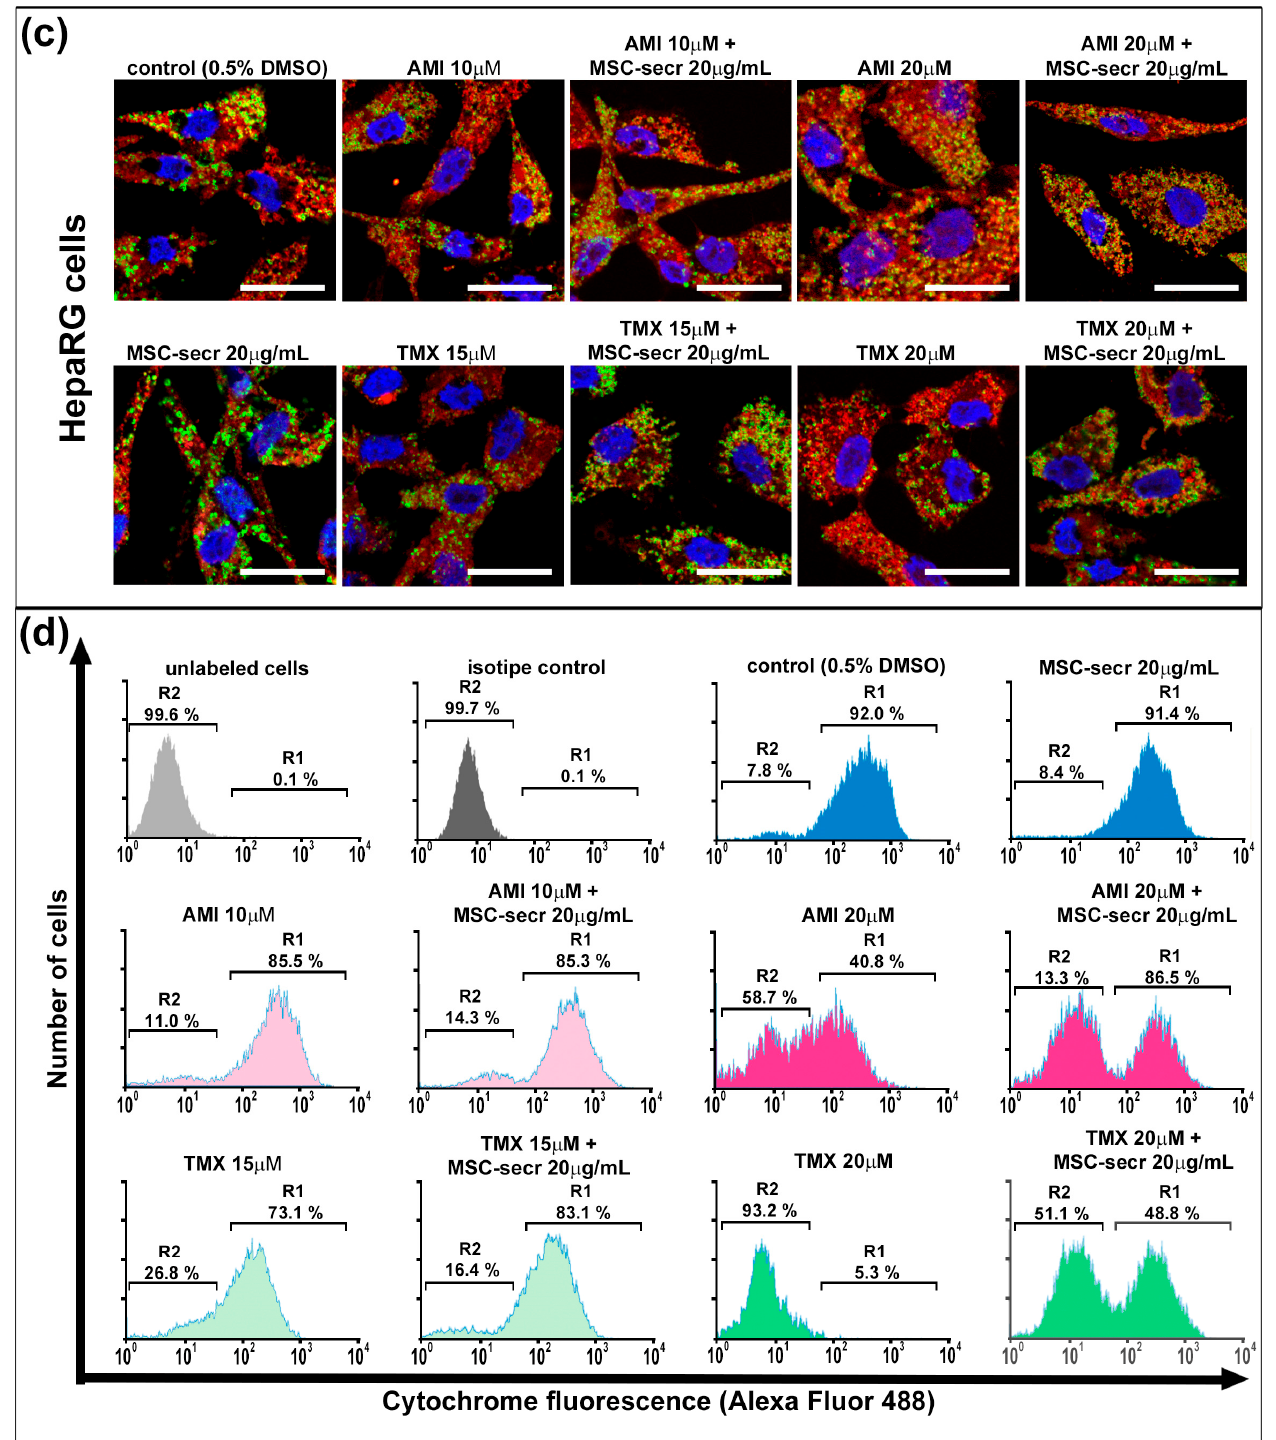
Figure 3. Coincubation with MSC secretome prevented cytochrome C release in HepG2 and HepaRG cells exposed to AMI or TMX. The release of cytochrome C was evaluated in HepG2 and HepaRG cells exposed to AMI or TMX alone or coincubated with MSC secretome (20 µg/mL) for 24 h. Mitochondrial cytochrome C release was detected by immunofluorescence in ( a ) HepG2 cells and ( c ) HepaRG cells. Representative micrographs of mitochondria (MitoTracker, red), cytochrome C (Cyt C, green), and their colocalization (merge, yellow); nuclei were counterstained with DAPI (blue). Cells with drug solvent (0.5% DMSO) were used as control group and showed maximal